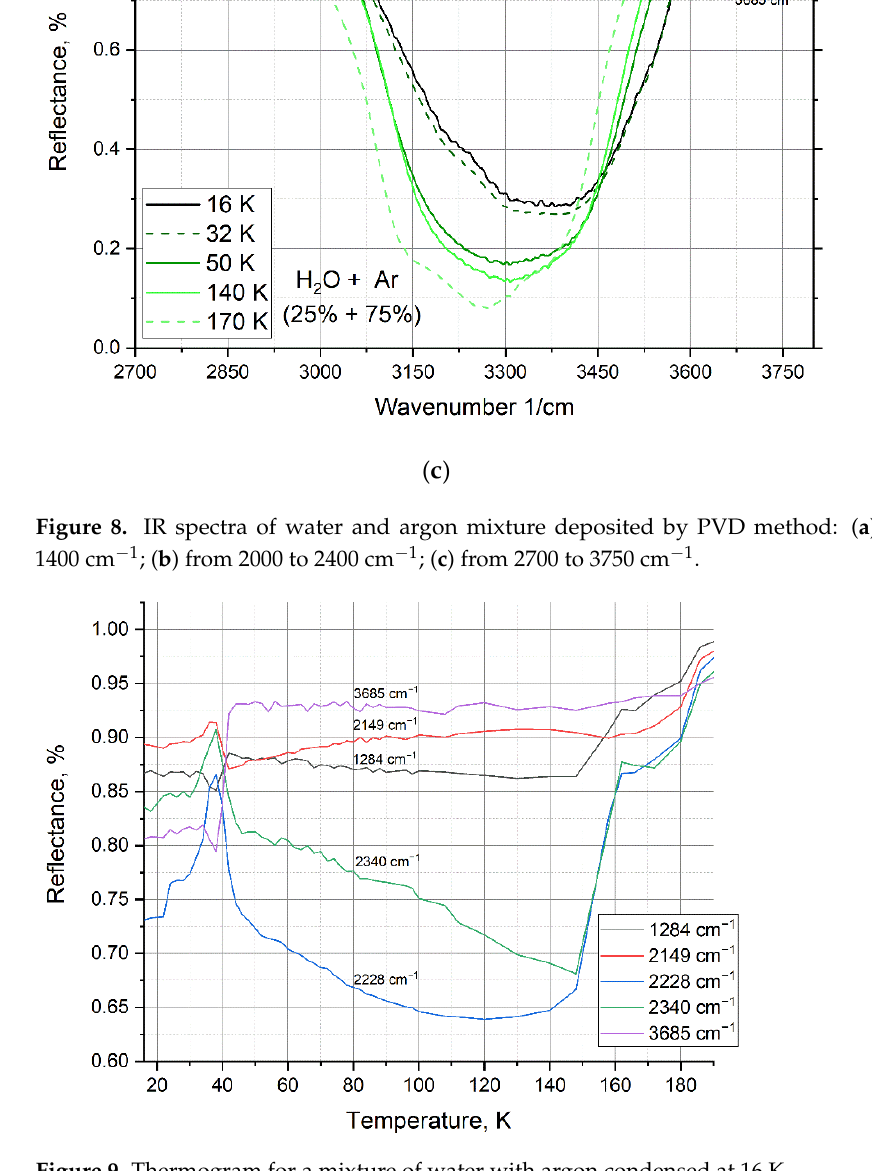
Figure 8. IR spectra of water and argon mixture deposited by PVD method: ( а ) from 1000 to 1400 cm −1 ; ( b ) from 2000 to 2400 cm −1 ; ( с ) from 2700 to 3750 cm −1 .